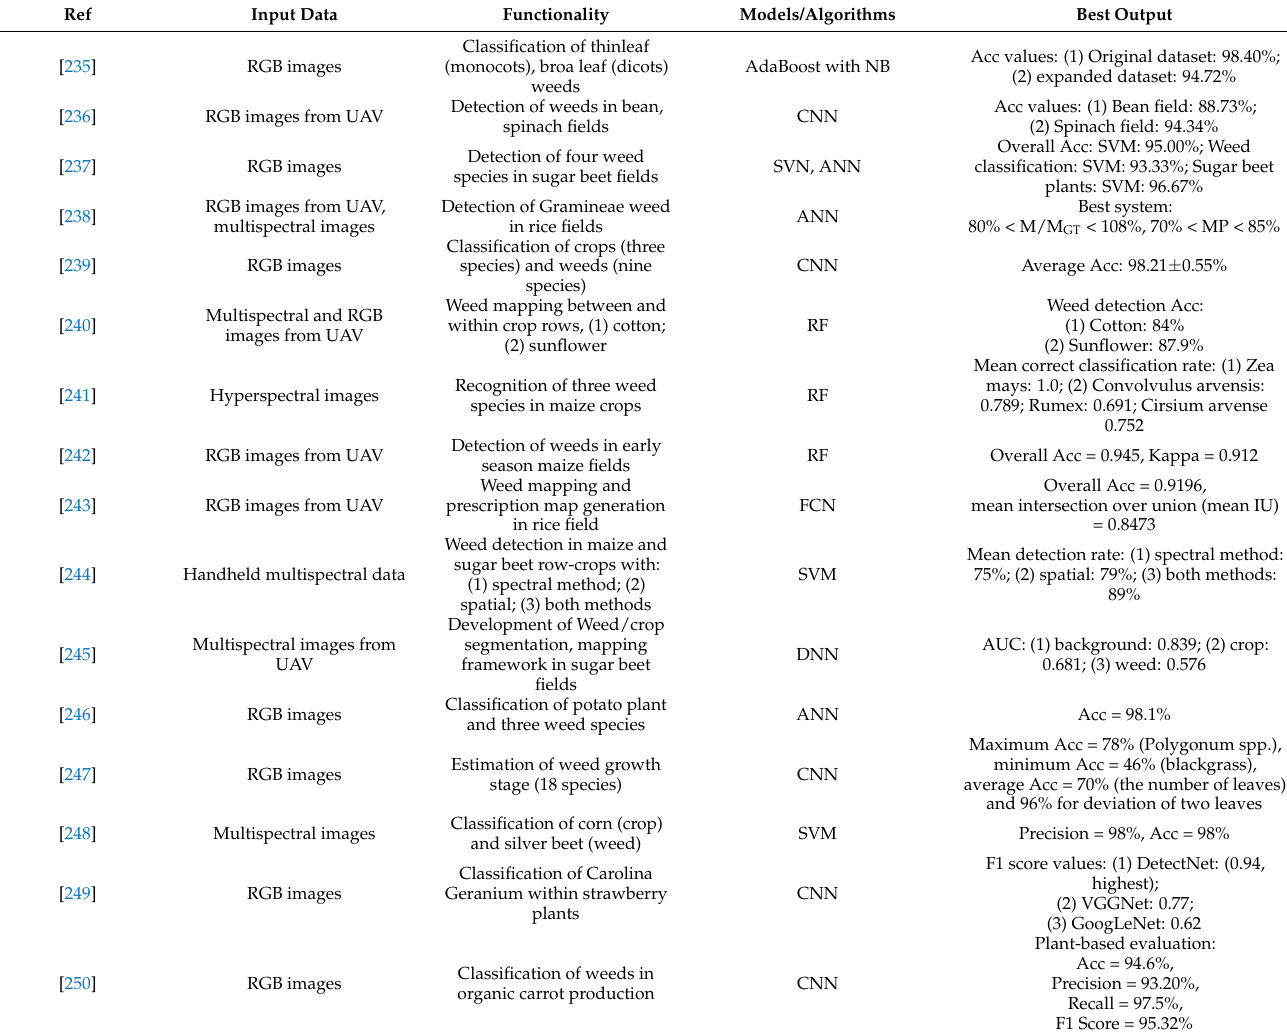
Table A3. Crop Management: Weed